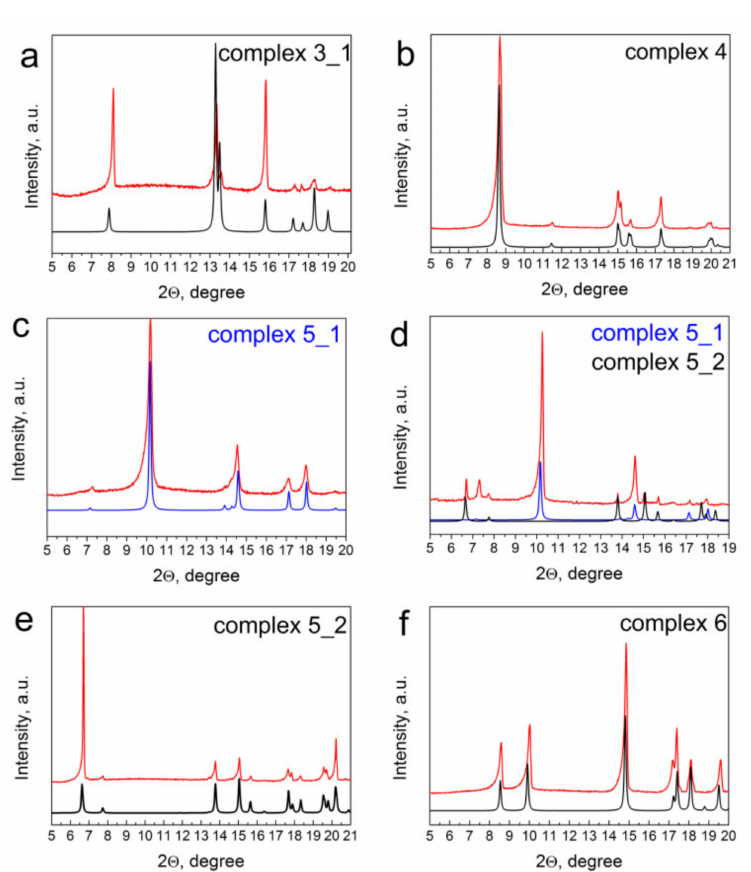
Figure 4. XRD data for the complexes 3 – 6 ( a – f ), including 5 polymorphs ( c – e ), compared with the corresponding theoretical diffractograms on the basis of the SXRD